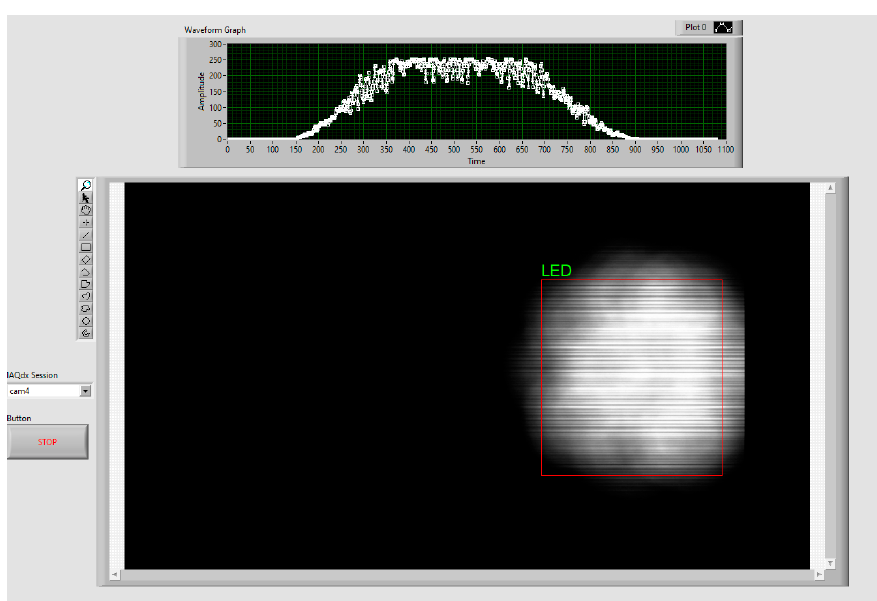
Figure 9. Rx interface.